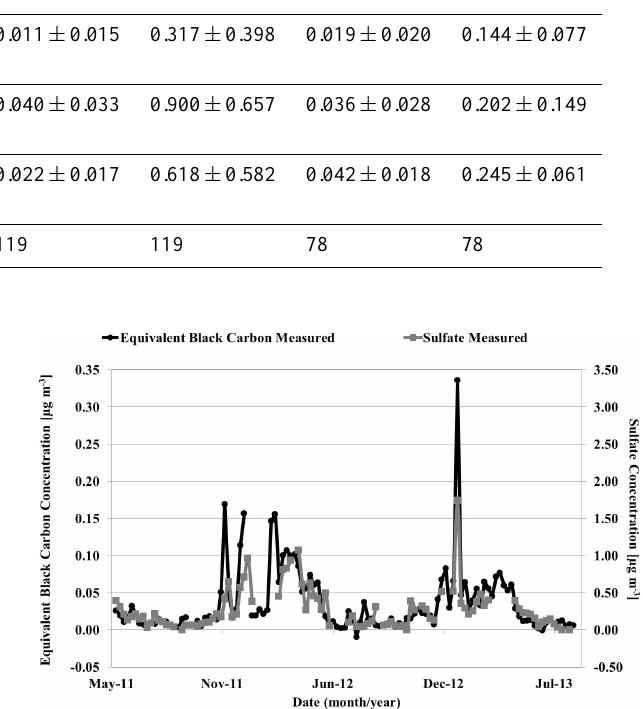
Table 1. Mean measured and modeled EBC/BC and sulfate concentrations together with mean measured EC and OC concentrations during the different seasons at VRS (Station Nord), North Greenland between May 2011 and August 2013. EBC Sulfate BC Sulfate EC OC measured measured modeled modeled measured measured [µgm − 3 ] [µgm − 3 ] [µgm − 3 ] [µgm − 3 ] [µgm − 3 ] [µgm − 3 ]